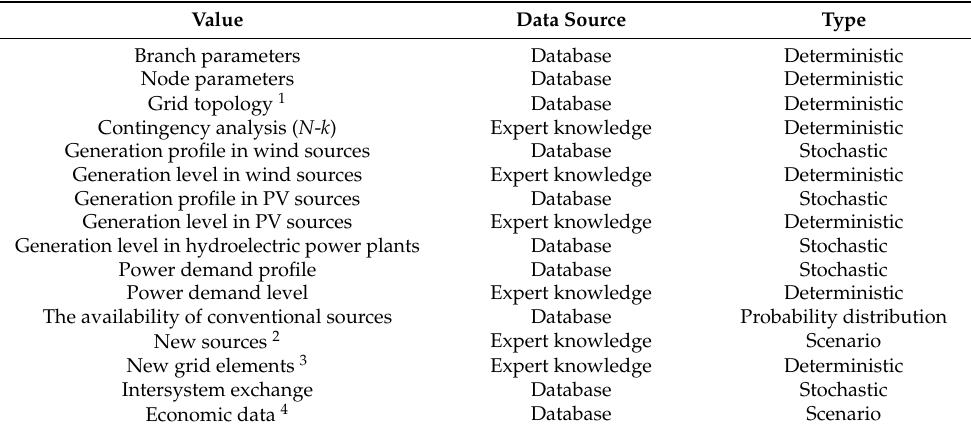
Table 1. List of input data used in the TEP study with the assignment of the type.